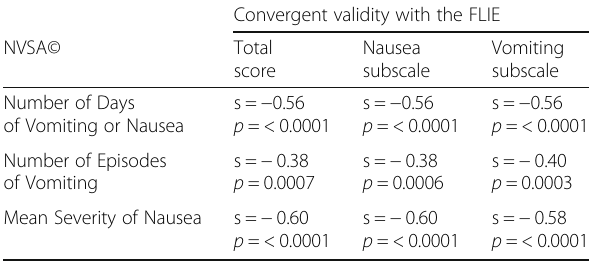
Table 3 Assessment of convergent validity of NVSA © scores with the FLIE: Week 1